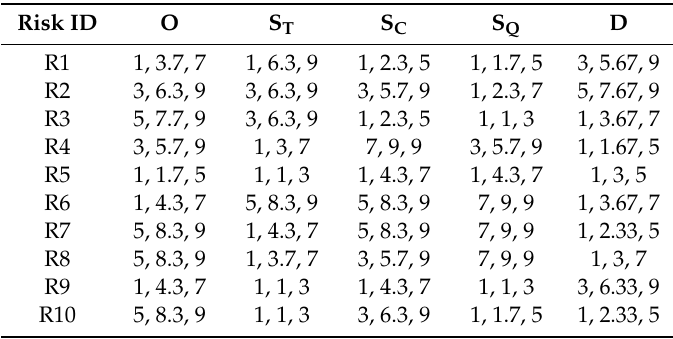
Table 8. Integrating the expert opinions.